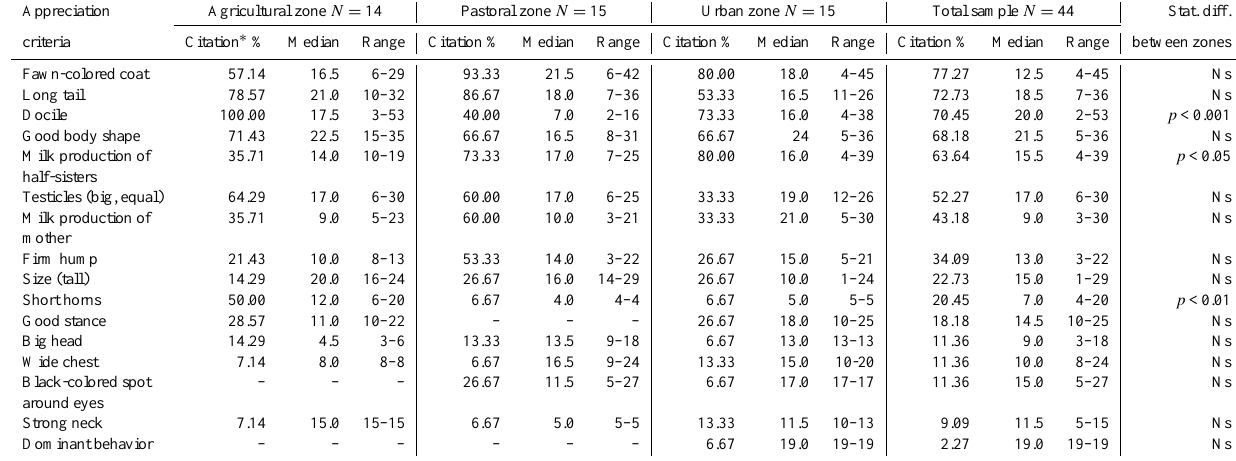
Table 1. Appreciation criteria for Azawak zebu sires in three production zones of Niger, citation in focus group discussions and proportional piling scores. Ns stands for not significant.